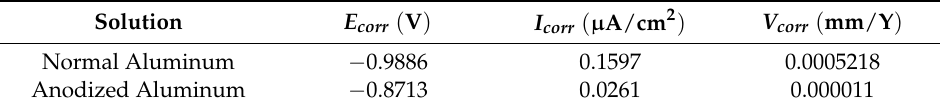
Figure 4. Polarization curve of normal and anodized aluminum plates. Table 2. Corrosion parameters of stainless steel in different